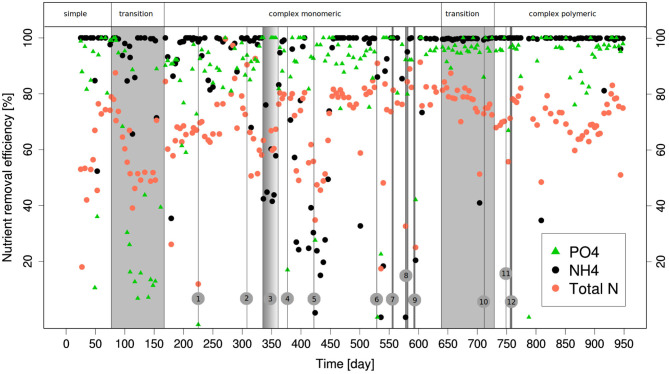
PO4--, NH4-, and TN-removal performance of the AGS during experiment 1. The process events susceptible to having had a negative impact on nutrient removal performance are numbered from 1 to 12. (1) No C-medium in the influent wastewater during eight cycles. (2) The leak of O2 detected since several days is corrected. (3) Few biomass in the reactors due to the duplication of the reactors and the feeding was not adapted. (4) Problem with pumping of NP-medium. (5) The pH of the bulk water was higher than 11 during at least 2 h. (6) The pH of the bulk water was higher than 11 during a period of time estimated to 24 h. (7) Problems with the recirculation pump possibly leading to lower shear stress during 2 days. (8) No trace elements in the influent during 4 days. (9) The influent was composed of twice the NP-medium and 200 mg O2
ml−1 of glucose during 2 days. (10) No feeding during the night. (11) Loss of biomass due to accidental change from 5 to 3 min of settling. (12) Lower concentrations of C-medium in the influent due to malfunctioning of the pumping.